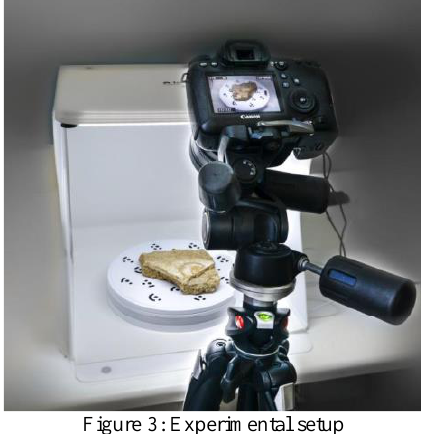
Figure 3: Experimental setup